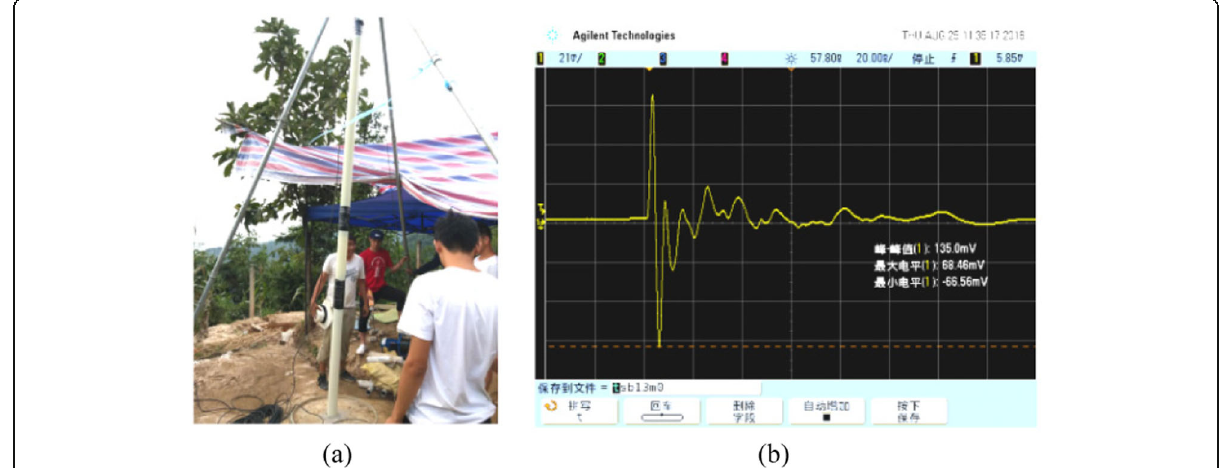
Fig. 16 Test site photos and cross-hole test waveforms. a Experimental test site. b Cross-hole test waveforms